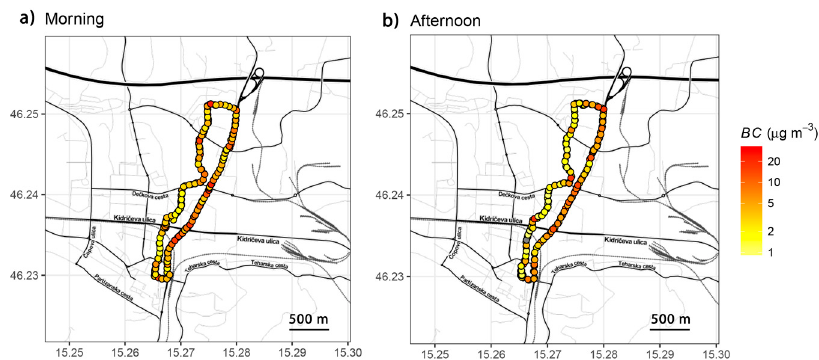
Table 2. Summary statistics of mobile BC measurements along the main and alternative route. Measurements are grouped to intersection segment (I) and straight segment (S) of the route (N— number of data points, SD—standard deviation).